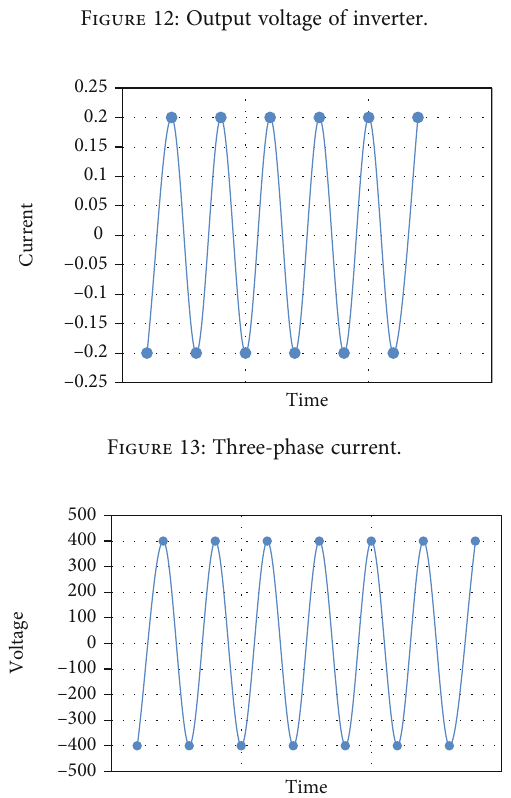
Figure 14: Three-phase